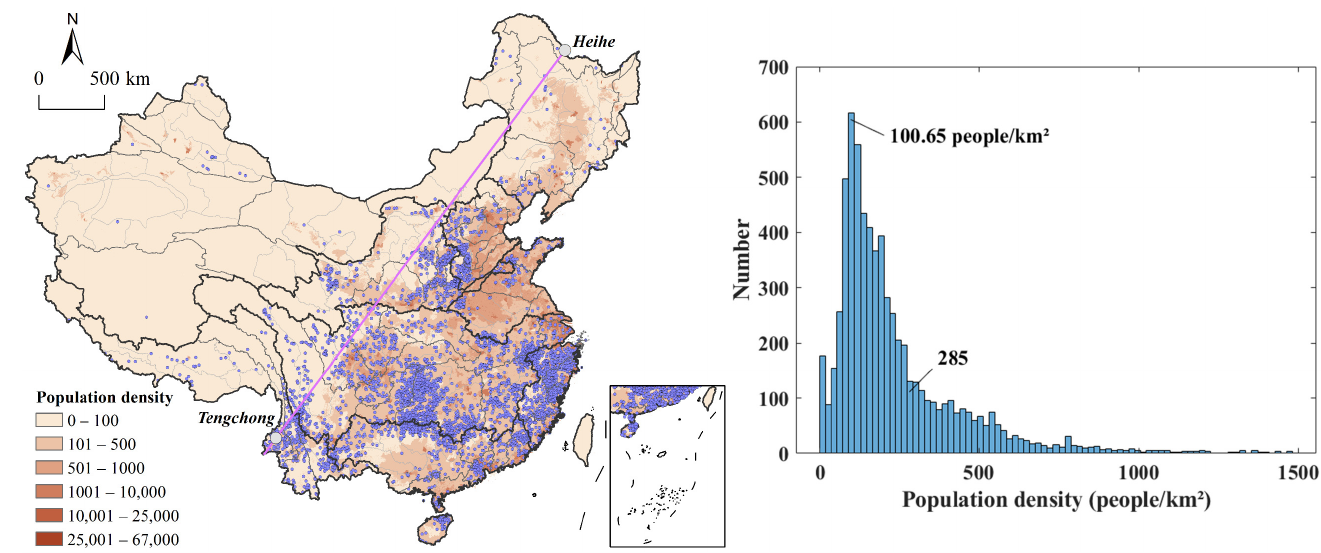
Figure 11. Relationships between traditional villages and population density in China.